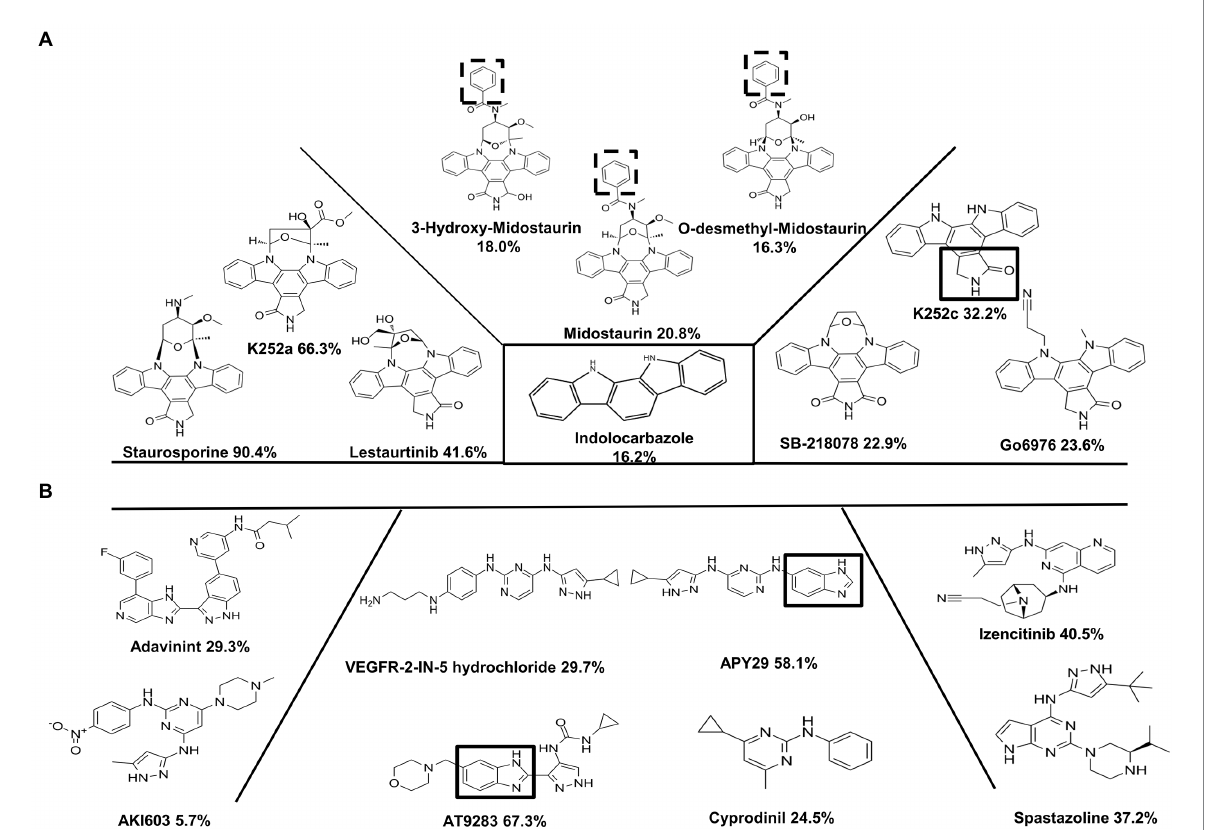
FIGURE 5 The analogs of Staurosporine, APY29, and AT9283. (A) The inhibition against ssSTK of Staurosporine and its analogs at 10 μ M. C2-carbonyl-pyrrole ring was marked by black box. N-methybenzamide substitution at C-4 ′ position of pyran ring of Midostaurin, 3-Hydroxy-Midostaurin and O-desmethyl-Midostaurin were marked by black dash box. (B) The inhibition against ssSTK of APY29, AT9283, and its analogs at 10 μ M. Benzimidazole nucleus was marked by black box. The experiments were carried out two times independently under the same